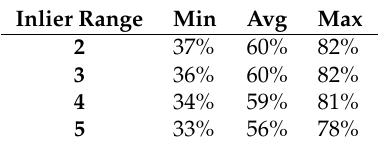
Table 3. Correctly synchronized video pairs as a function of ± ∆ R ; σ = 1, O . R . = 4, and N . C . = 3. Inlier Range